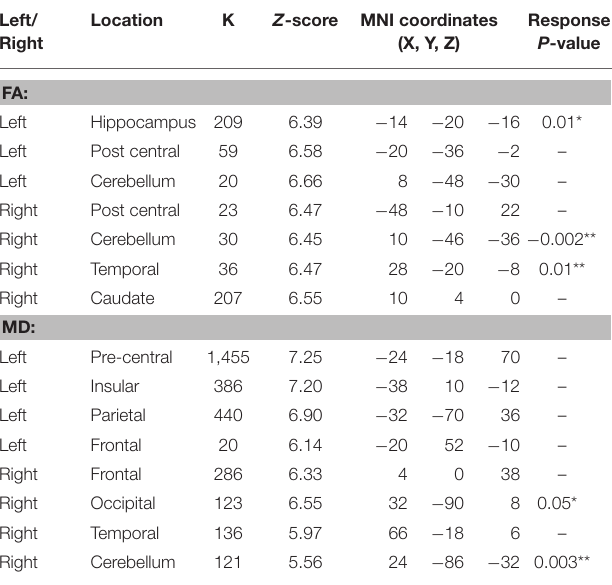
TABLE 3 | Significant changes in DTI parameters after bumetanide administration in regions that found abnormal in pre-treatment vs. control subjects using a correction for multiple comparisons (36) at the cluster level ( p <